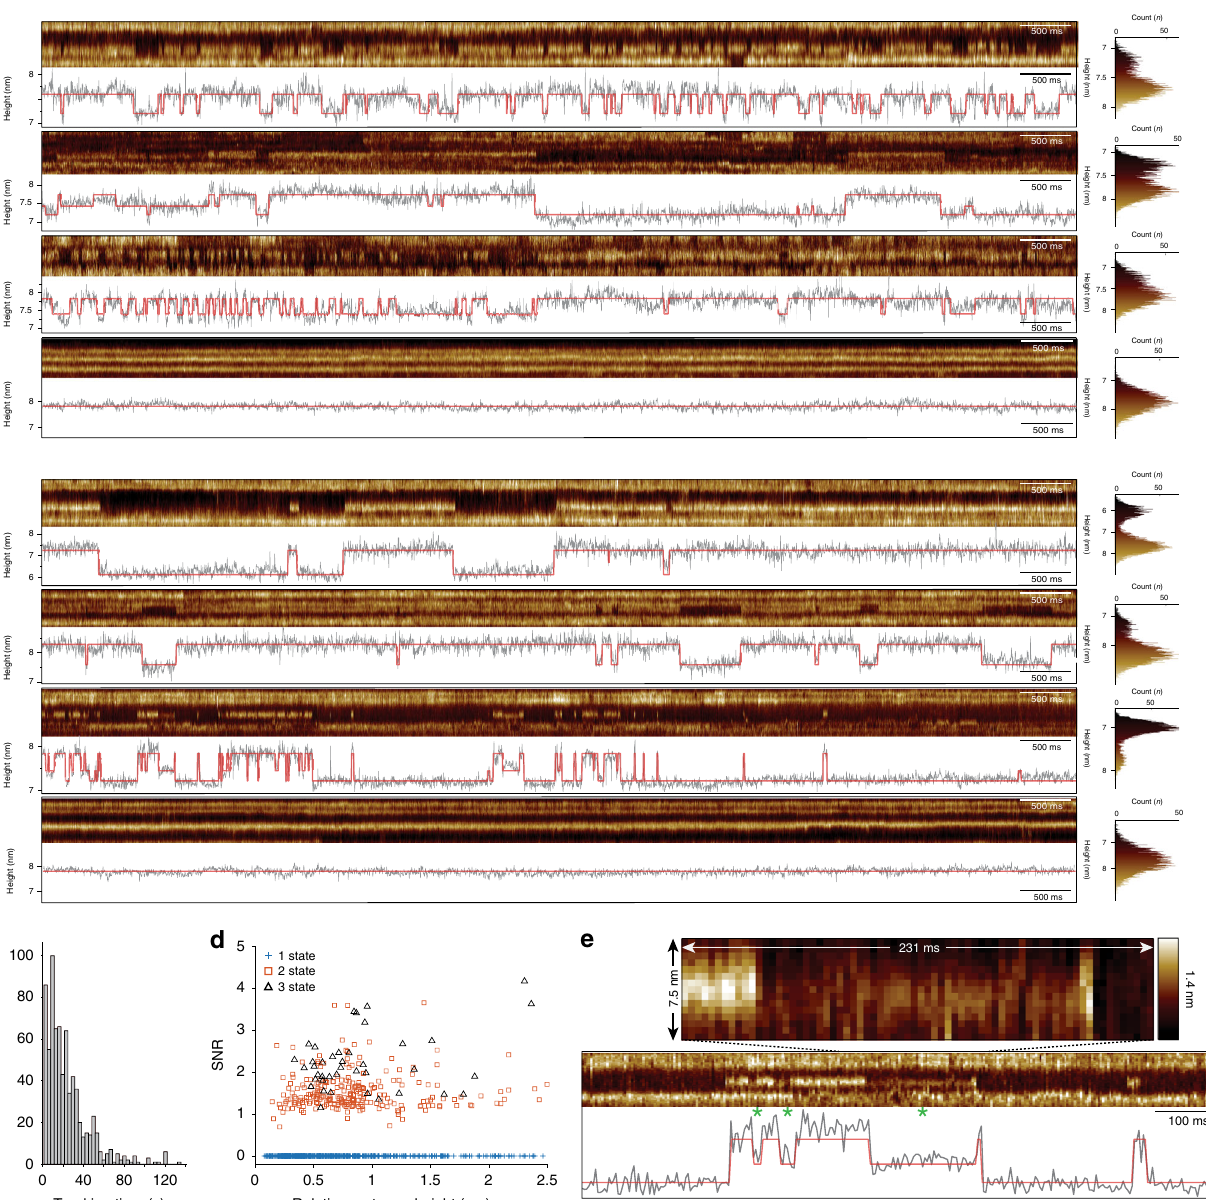
Fig. 3 Elevator dynamics of single unlabeled Glt Ph transporter domains. HS-AFM-LS raw data kymographs and height/time traces recorded in apo a and transport b conditions. All kymographs were recorded at 3.3 ms line acquisition speed. The height/time traces (gray) report the movements of the protomer in the center of the kymograph and are overlaid by the state-transition trace (red). The last kymograph and height/time trace in each condition shows traces of inactive protomers (see Table S2). Right: height distributions of the protomers under investigation. c Length distribution of GltPh transport domain tracking in HS-AFM-LS experiments ( n = 762). d Signal-to-noise ratio (SNR) plotted against the protomer relative height over membrane in the outward-facing state for all analyzed 762 individual protomers. Traces assigned with 1, 2, and 3 amplitude states are represented by blue crosses, red squares, and black triangles, respectively. e A representative raw data kymograph and height/time trace (gray) overlaid by the idealized state-transition trace (red) of a transport domain visiting three states. Asterisks indicate intermediate state intervals. Top: pixel-by-pixel display of 7.5 nm lateral dimension and 231 ms raw data of the center (dashed lines) of the 3-state kymograph shown below, allowing the viewer to observe the SNR and pixel-statistics of HS- AFM-LS. The full false color scale of the pixels shown is 1.4